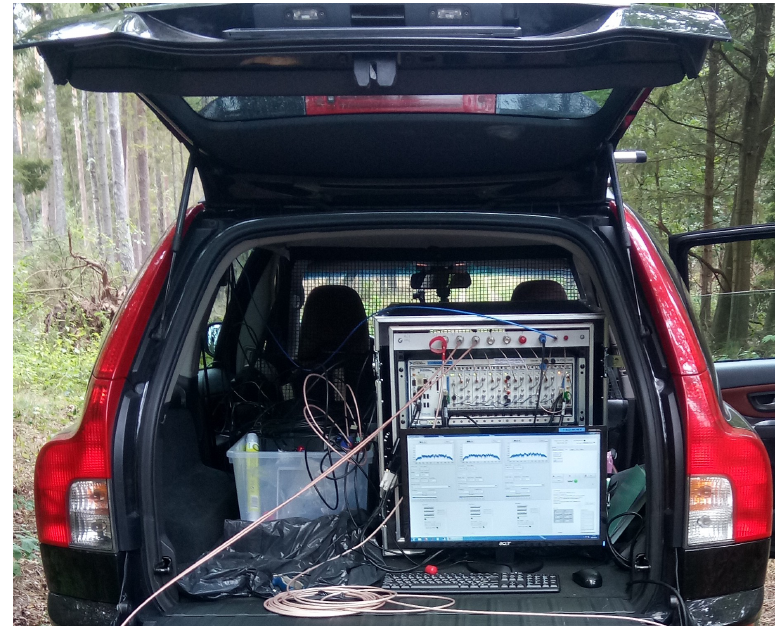
Figure 5. Digital multichannel signal recorder.